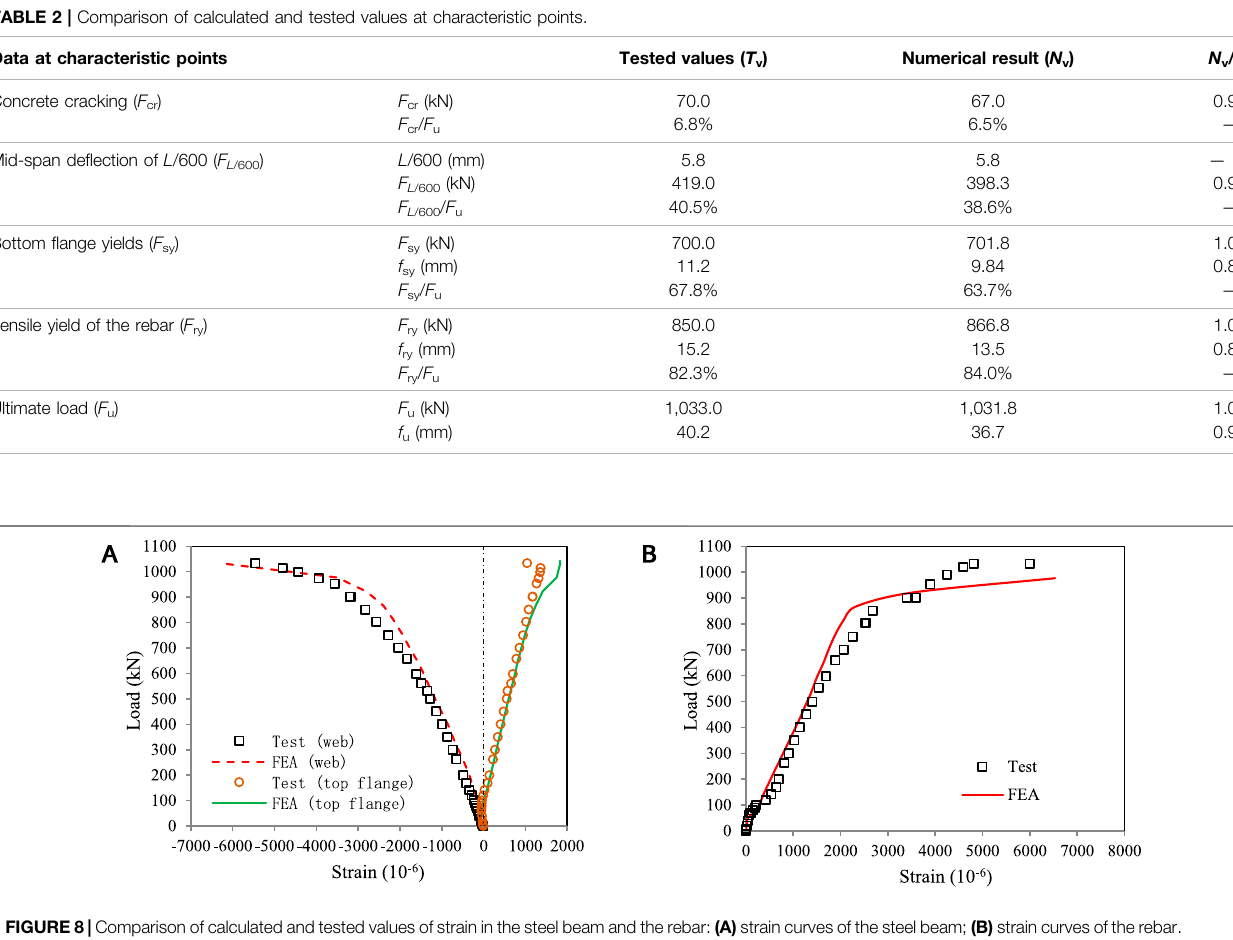
Frontiers in Materials |